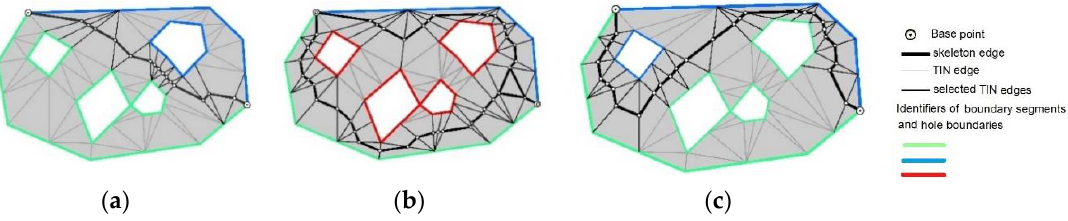
Figure 13. Skeleton modification based on three criteria: ( a ) the skeleton should be located in the center of the complex polygon between holes (islands); ( b ) the skeleton should omit holes (islands) and should be located along the external boundary of the complex polygon; ( c ) the skeleton can also be modified by changing the ID of hole boundaries.